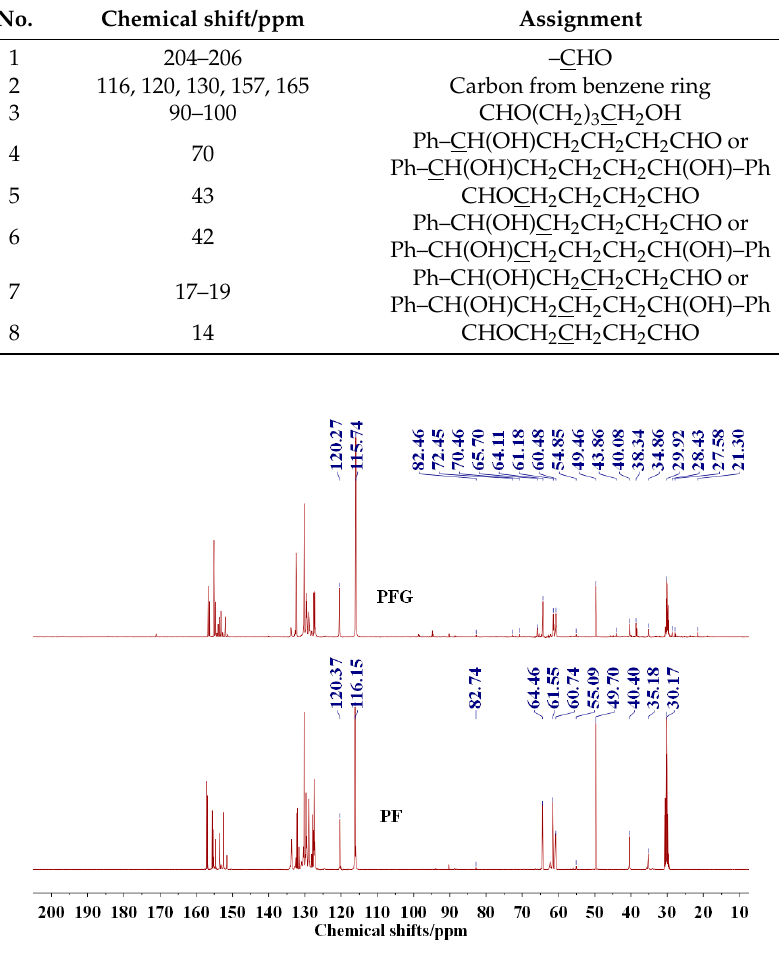
Figure 2. 13 C-NMR spectra of PFG and PF resin.